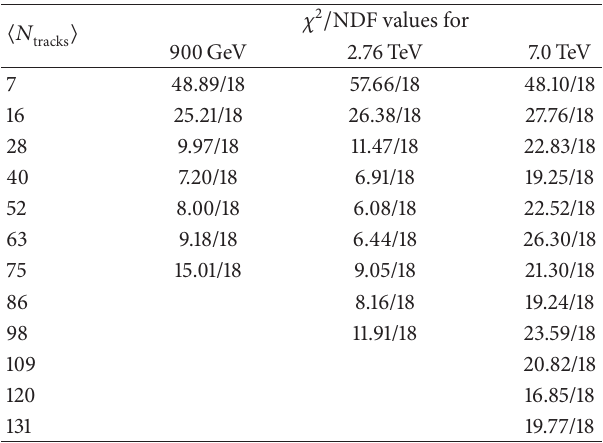
Figure6:Theinvariantyieldspectraof (𝜋 + +𝜋 − )/2 [21],asafunction of 𝑚 𝑇 −𝑚 for 𝑝+𝑝 collisions at √𝑠 = 2.76 TeV. The yields are shown ⟩ 7, 16, 28, 40, 52, 63, 75, 86, and 98. The spectra are scaled for ⟨𝑁 tracks up for clarity by a factor of 3 𝑖 , where 𝑖 = 0, 1,2, 3, 4,5, 6, 7 , and 8. The solid lines show the Tsallis fits. Table 3: Values of the 𝜒 2 / NDF for the Tsallis fits in different event multiplicities.